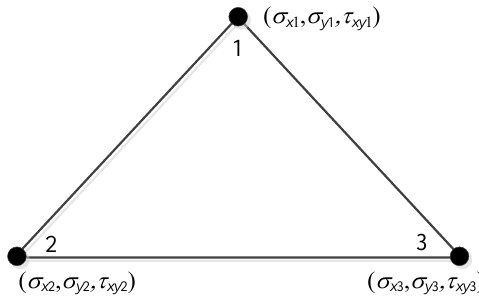
Figure 1. The lower bound element.